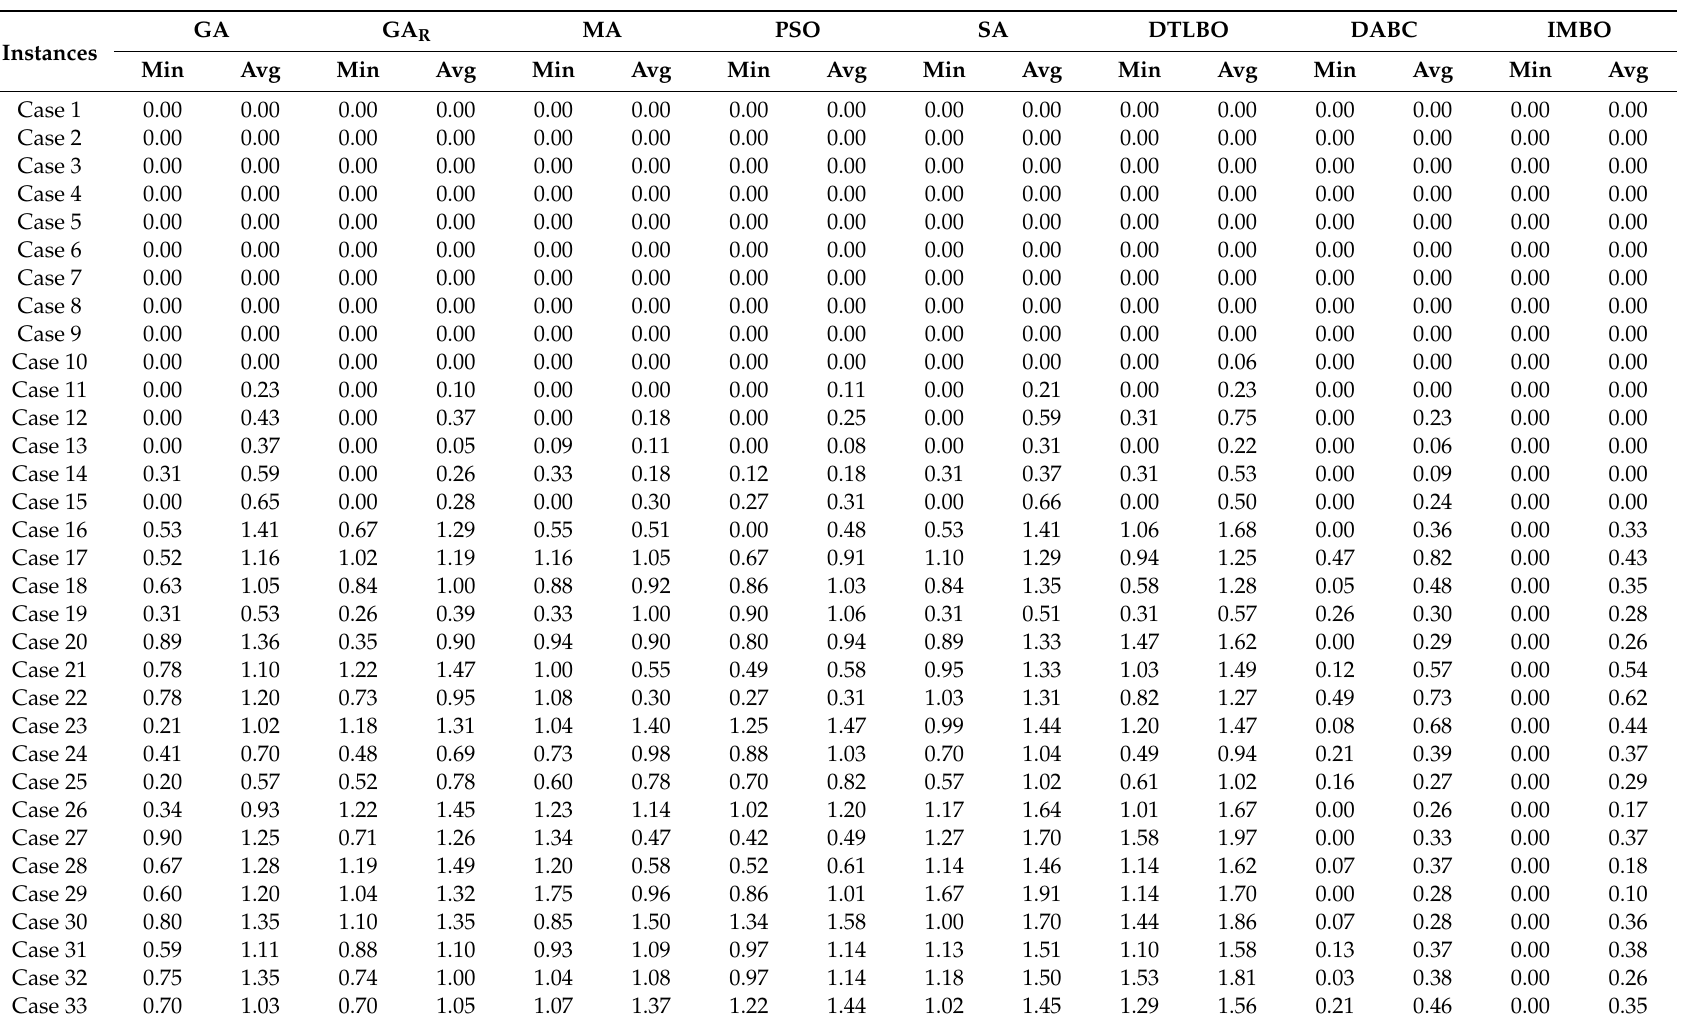
Table 11. Comparison results for minimum RPD and average RPD when ρ =